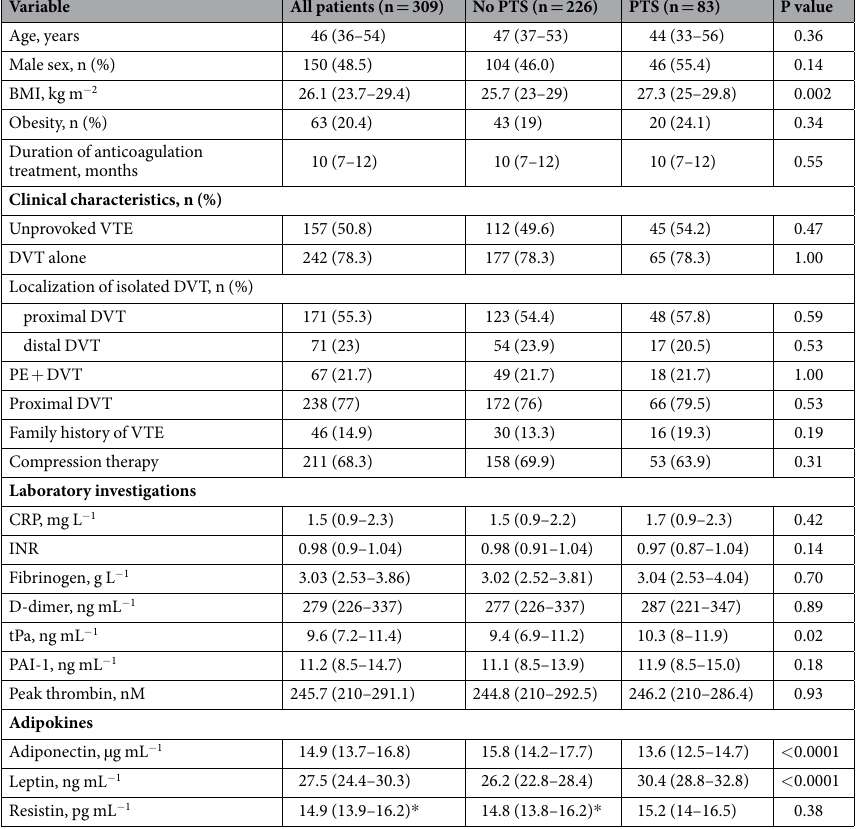
Table 1. Patient Characteristics. Values are given as mean ± standard deviation (SD), median (interquartile range) or number (percentage). PTS, post-thrombotic syndrome; BMI, body mass index; VTE, venous thromboembolism; DVT, deep vein thrombosis; PE, pulmonary embolism; CRP, C-reactive protein; INR,